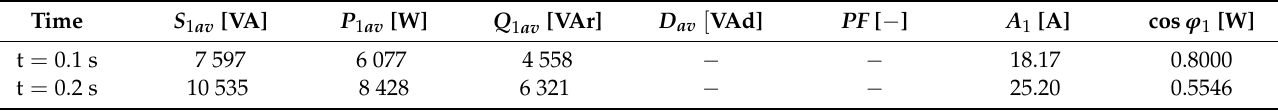
Table 34. Classical calculation before and after the change (at steady states).